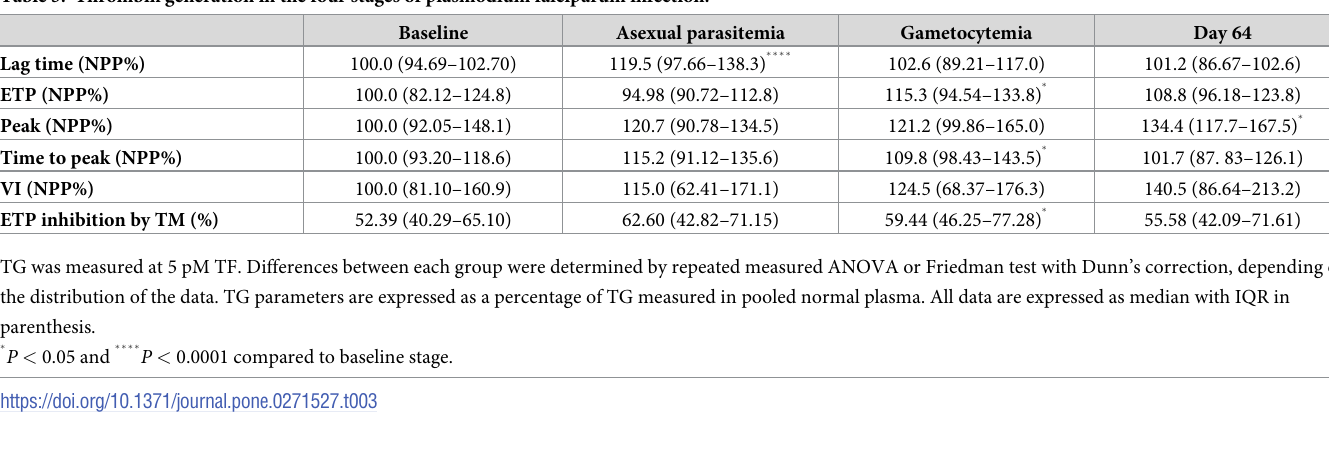
Table 3. Thrombin generation in the four stages of plasmodium falciparum